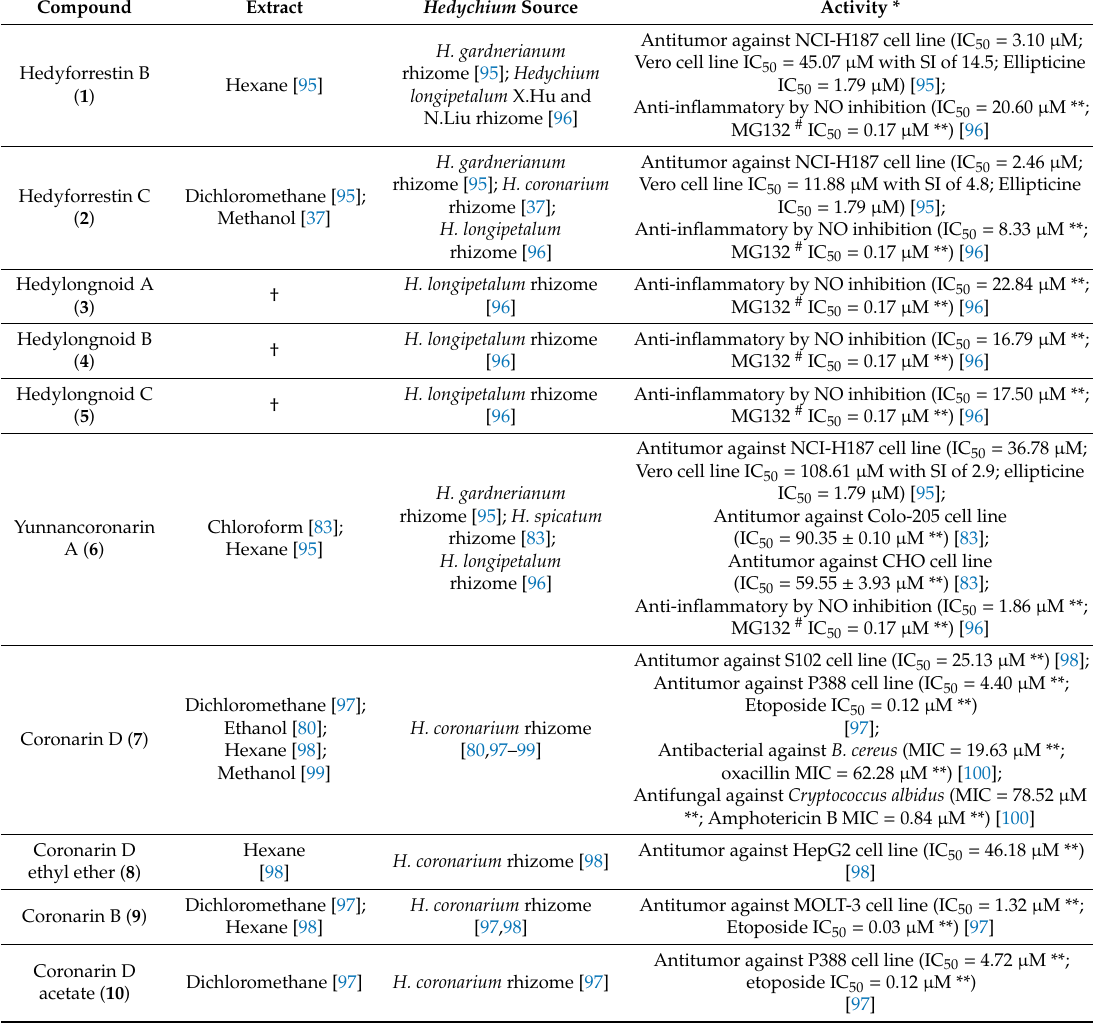
Table 2. Secondary metabolites isolated from Hedychium extracts with proven